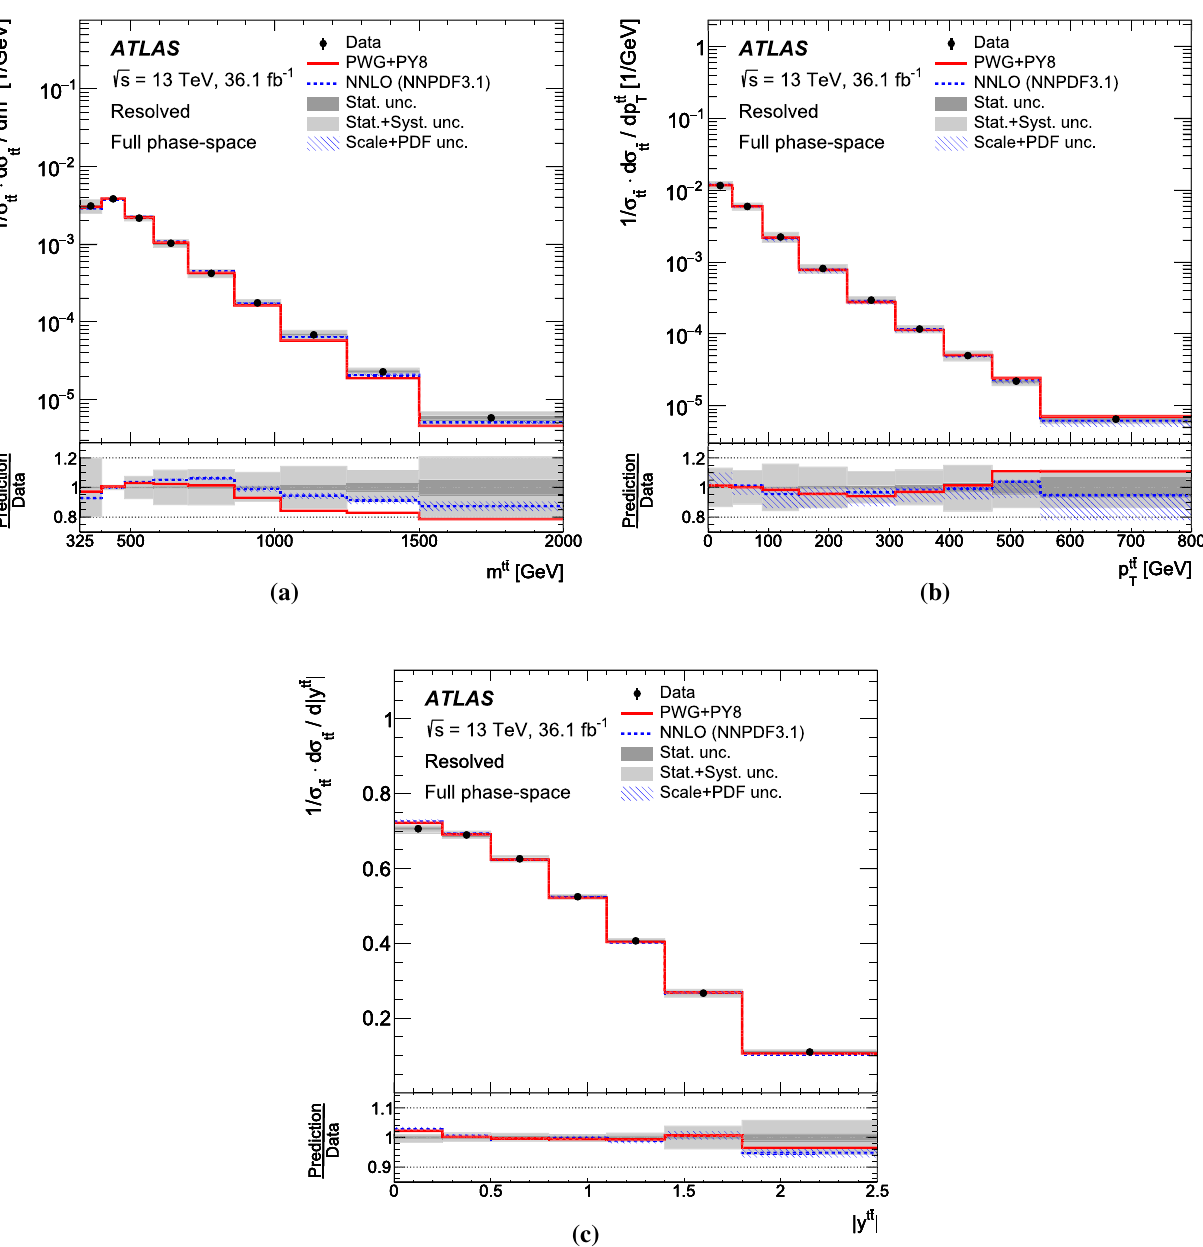
Fig. 56 Parton-level normalised differential cross-sections as a func- tion of a the mass, b p T and c absolute value of the rapidity of the t ¯ t system in the resolved topology, compared with the NNLO predic- tions obtained using the NNPDF3.1 NNLO PDF set and the predictions obtained with the Powheg + Pythia8 MC generator. The hatched band